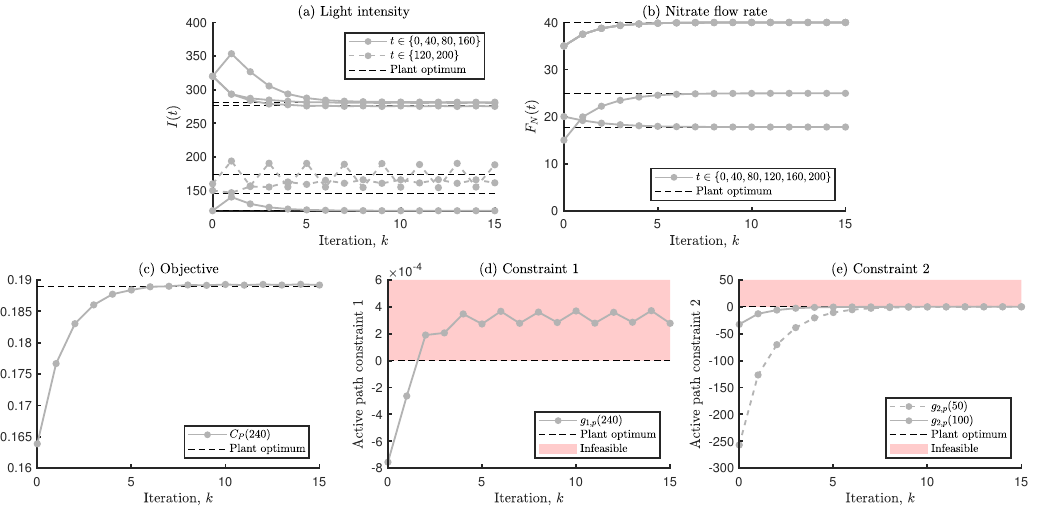
Figure 13. Standard MA inputs and NLP functions. Top row, unstable inputs shown with a dashed line, stable with a solid line. Bottom row, objective and constraints which are active at plant